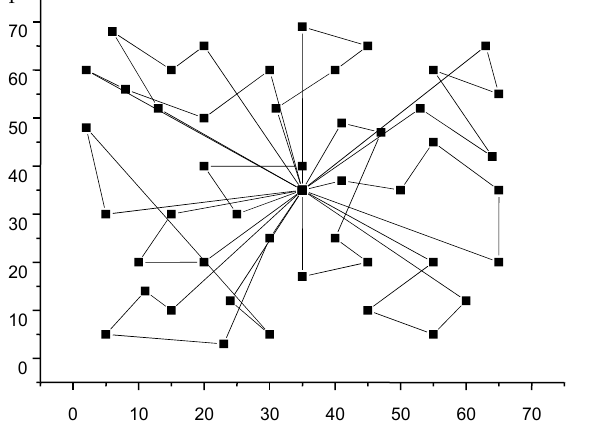
Figure 5. Optimal Figure 5. Optimal route. Table 4. Comparison of scheme costs for R101.